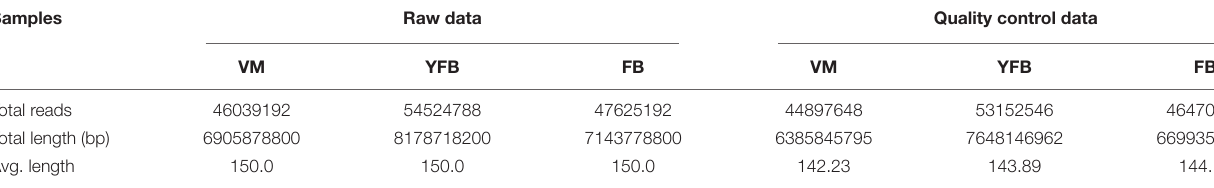
TABLE 2 | Throughput and quality of Illumina sequencing of the Floccularia luteovirens transcriptome. Samples Raw data